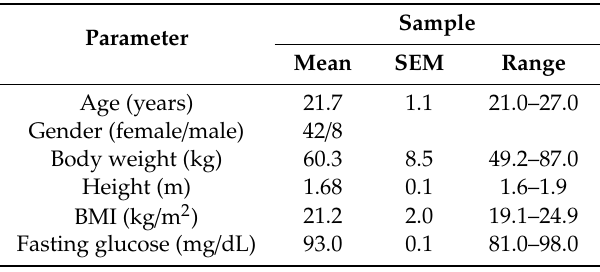
Table 2. Baseline clinical and anthropometric characteristics (mean ± standard error of the mean (SEM)) of participants ( n = 50) involved in the